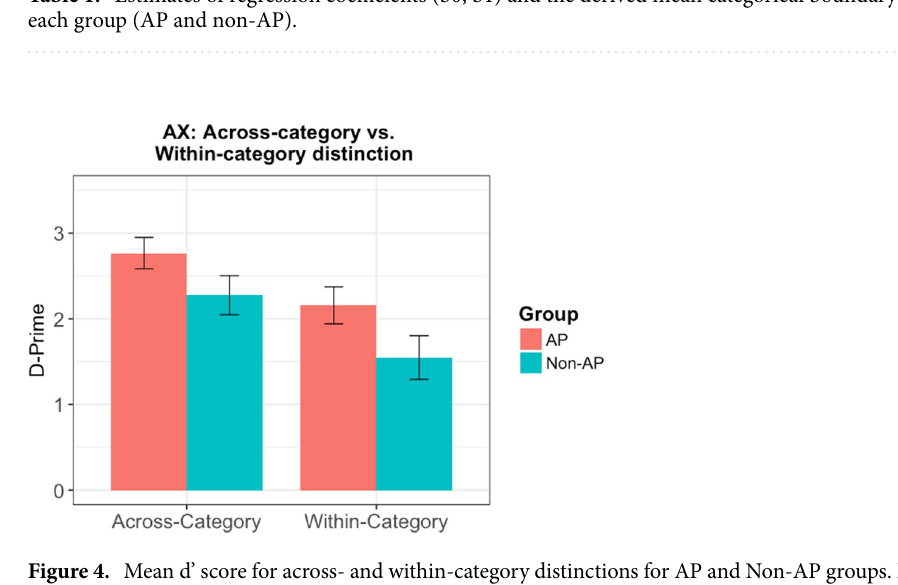
Figure 4. Mean d’ score for across- and within-category distinctions for AP and Non-AP groups. Error bars = ± 1